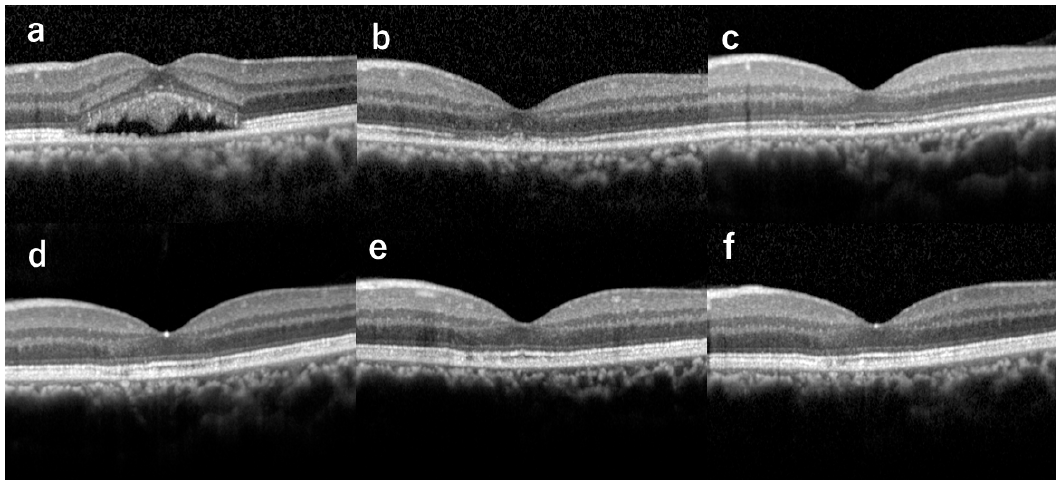
Figure 2. Optical coherence tomography images of the left eye of a 41-year-old male (Case 1) with chronic central serous chorioretinopathy showing serial changes of the ellipsoid zone (EZ) and interdigitation zone (IZ), from before half-dose photodynamic therapy (hdPDT) to complete recovery of the two zones after hdPDT. In this case, the serous retinal detachment was completely absorbed at 1 month after hdPDT. ( a ) Before hdPDT, EZ and IZ at the fovea were both absent. ( b ) At 1 month after hdPDT, EZ and IZ were both absent. ( c ) At 3 months, EZ was continuous and IZ was absent. ( d ) At 6 months, EZ was continuous and IZ was fragmented. ( e ) At 9 months, EZ was continuous and IZ was fragmented. ( f ) At 12 months, EZ and IZ were both continuous.